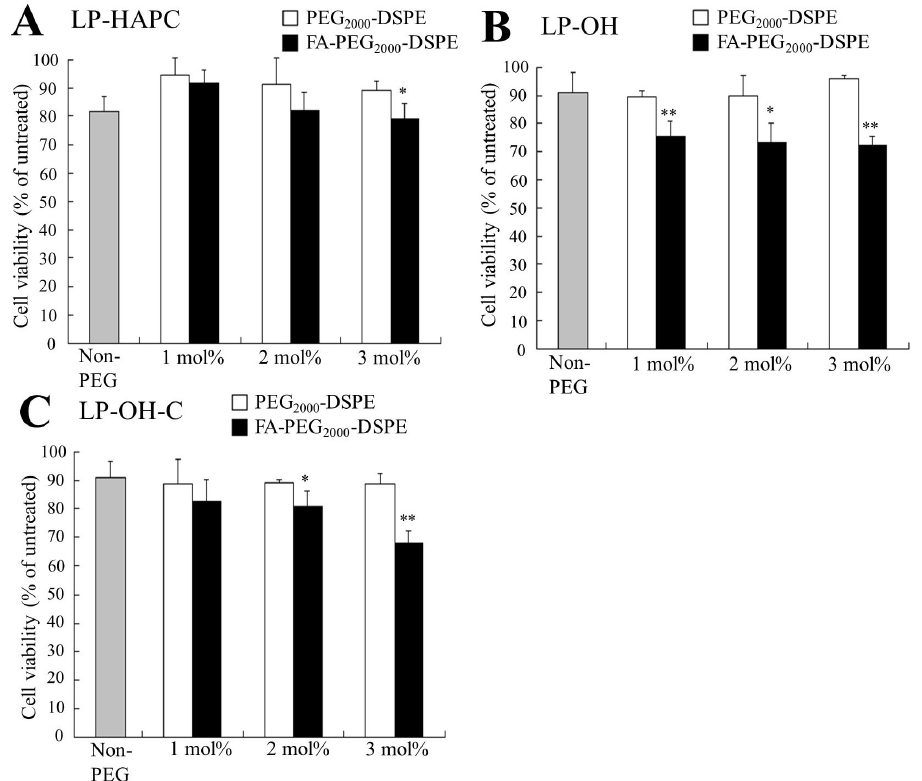
Figure 3. Effect of FA-PEG-modification of cationic liposomes on cell viability 24 h after transfection with FA-PEG-modified siRNA lipoplexes into KB-Luc cells. ( A ) LP-HAPC-1–3mol%PEG 2000 and